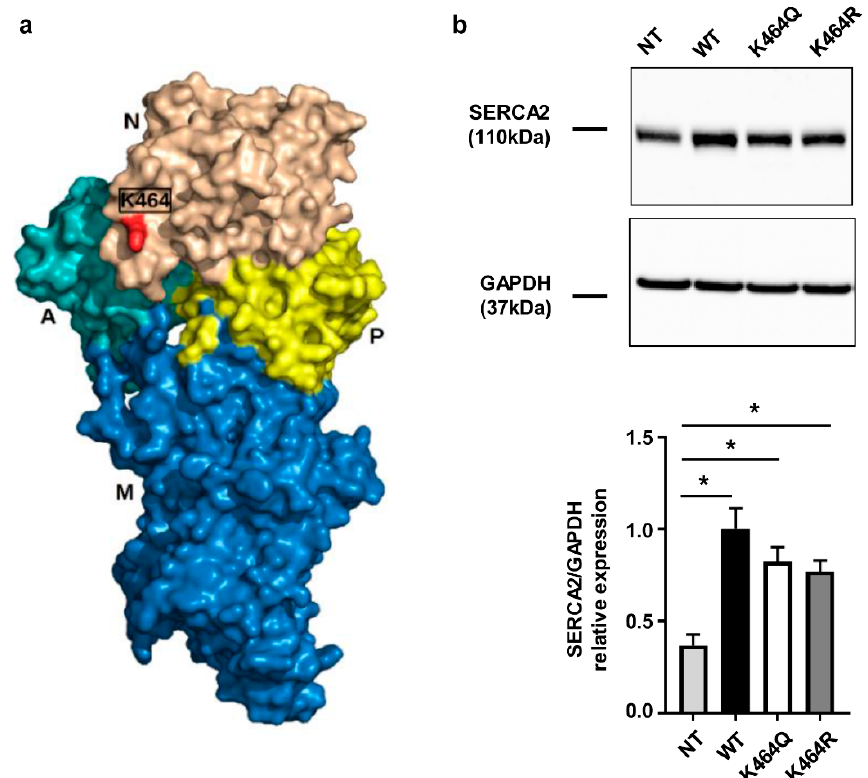
Figure 4. Analysis of human SERCA2a mutants transfected in HEK cells: bioinformatics prediction and protein expression. ( a ) Molecular surface view of predicted hSERCA2a. Domains are visualized in different colors: Actuator (A) in light blue, transmembrane (M) in dark blue, phosphorylation (P) in yellow and nucleotide-binding (N) in beige. K464 is highlighted in red; ( b ) Western blot analysis of SERCA2 expression in stable transfected HEK cells. Densitometry is reported in the bar graph ( n = 8). Ordinary one-way ANOVA followed by Bonferroni’s multiple comparison: p < 0.005 vs. NT.